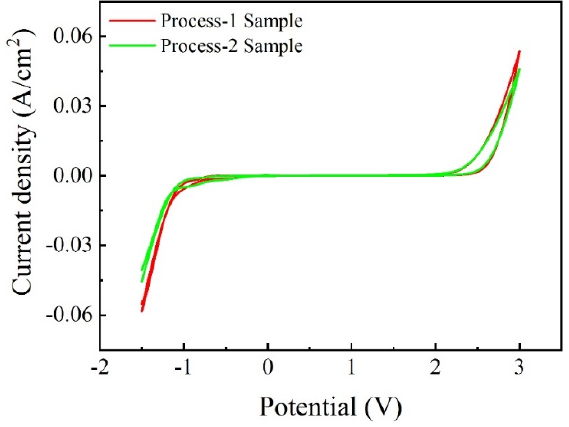
Figure 8. Cyclic voltammetry (CV) curves of Ti / BDD coated electrodes prepared by two processes. 252